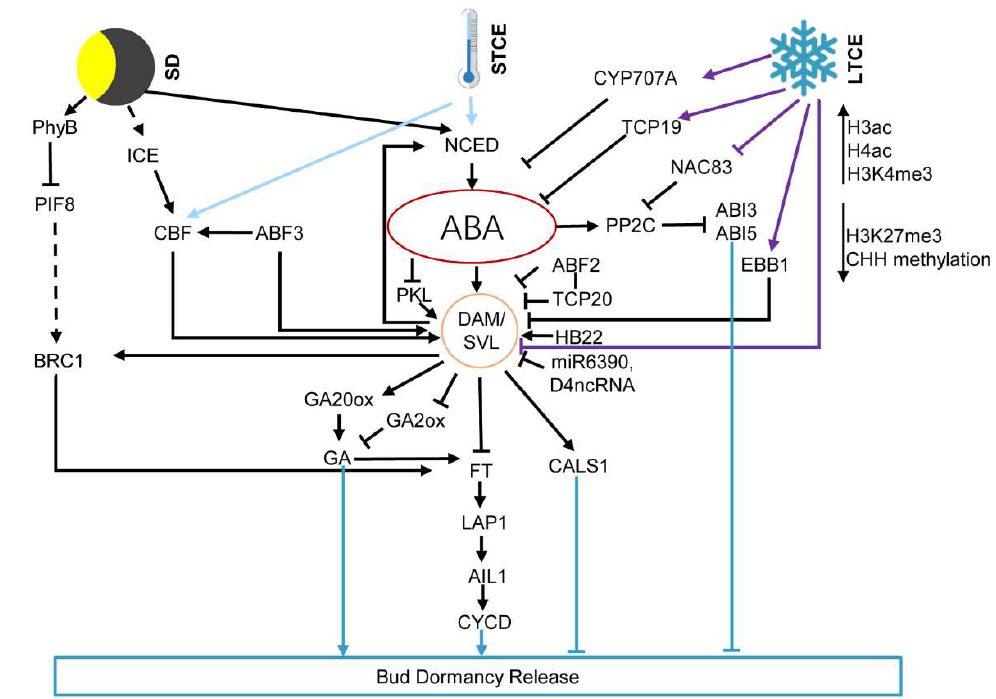
Figure 1. ABA integrates environments signaling in regulating bud dormancy. During dormancy induction, SD and STCE stimulate ABA biosynthesis and induce bud dormancy via DAM and ABA signaling that blocks the plasmodesmata and slow down the cell cycle. After long term of chilling, endogenous ABA is decreased by cis - and trans - regulation. DAM/SVL is repressed when ABA was decreased, resulting in promoted GA in cells and degradation of callose at the plasmodesmata. Enhanced cell communication leads to active cell division and bud break. Note that this overview summarizes interactions reported in different species, which are not necessarily occurring simultaneously. Full lines and dashed lines specify established and putative/indirect regulation, respectively. LTCE: long term cold exposure; SD: short day; STCE: short term cold exposure.